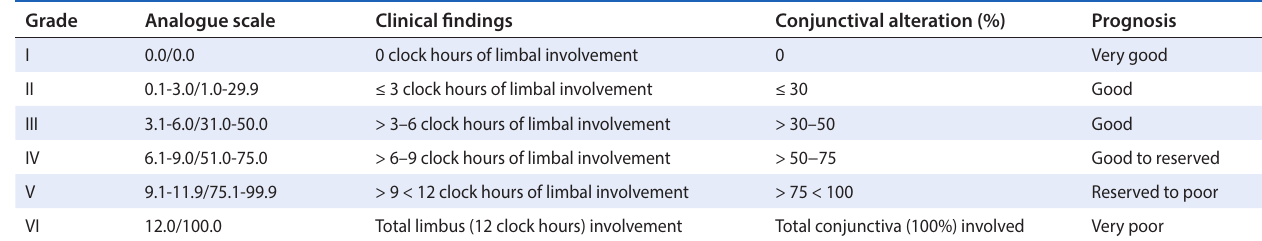
Table 2: Dua’s classification 12